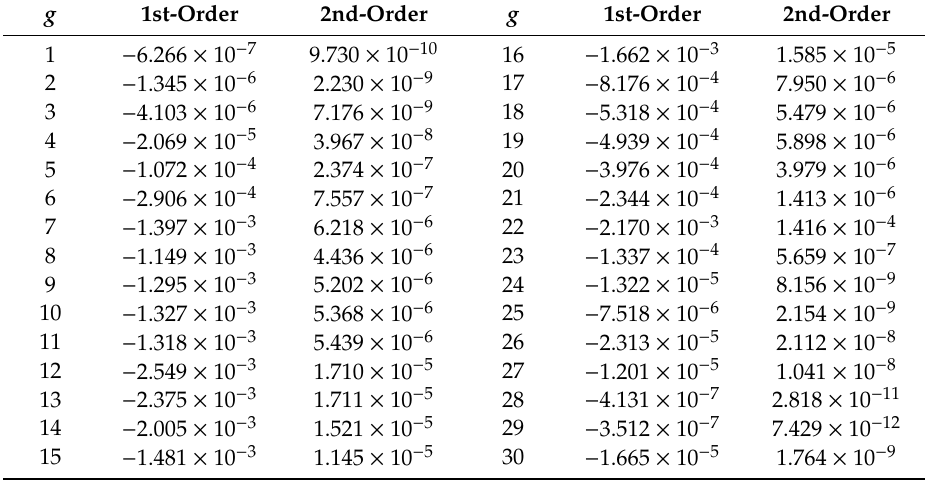
(cid:17)(cid:16) (cid:17) (cid:16) σ g ∂ L / ∂σ g / L , g = 1, ... ,30, t , i = 4 t , i = 4 (cid:16) (cid:17)(cid:16) (cid:17) ∂ 2 L / ∂σ g ∂σ g σ g σ g / L , g = 1, ... ,30, for isotope t , i = 4 t , i = 4 t , k = 4 t , k = 4